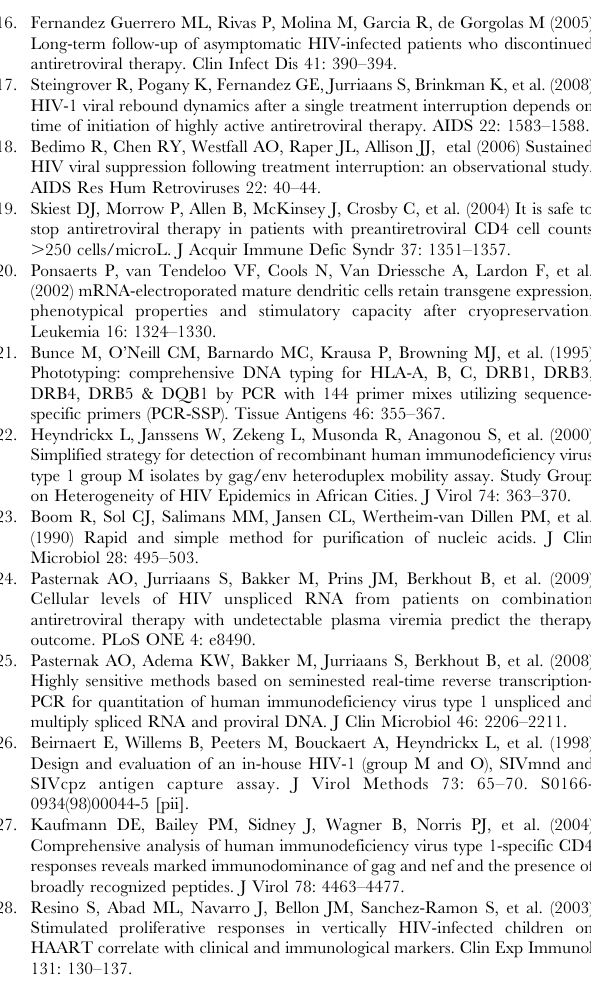
Table S1 Supplementary data avidity of Gag (A) and Pol (B) specific T-cells in all patients. A : number of peptides of Gag and Pol that have reacted in the epitope mapping ELISPOT. B : Number of deduced epitopes. This number can be equal or lower than in the ‘‘peptides reacting’’ column, due to the overlapping nature of the peptides format used i.e. a single epitope can be present in 2 or 3 overlapping peptides. C : Number of peptides tested: if not enough cells were available to test all epitopes, only those were used that were predicted to be